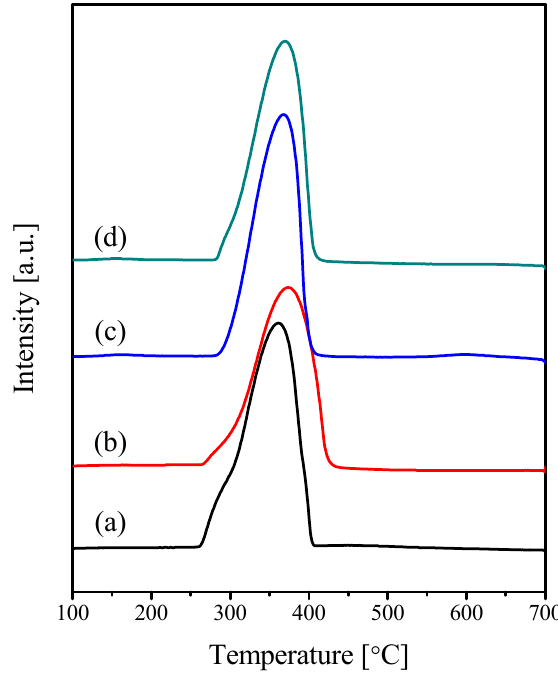
Figure 10. H 2 ‐ TPR profiles of the calcined NiO. ( a ), Gd/NiO ( b ), La/NiO ( c ), and Sm/NiO ( d ).